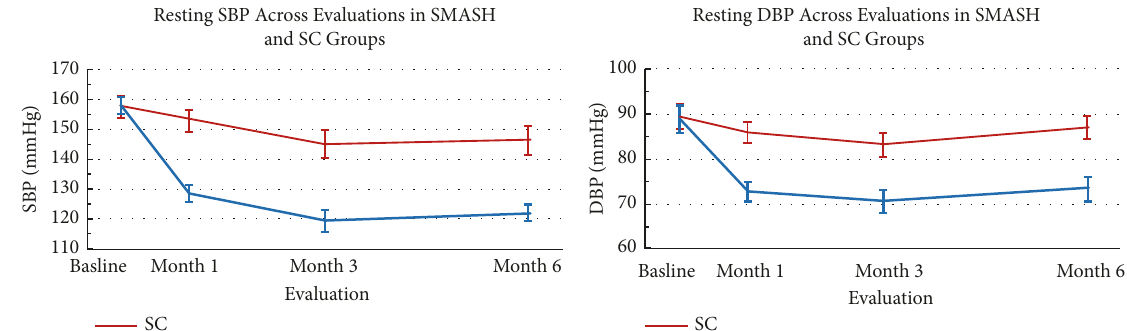
Figure 2: Blood pressure control was better in the intervention group (blue) in comparison to control (red). SBP: systolic blood pressure; DBP: diastolic blood pressure; SC: standard control; SMASH: smartphone medication. Source: [5].